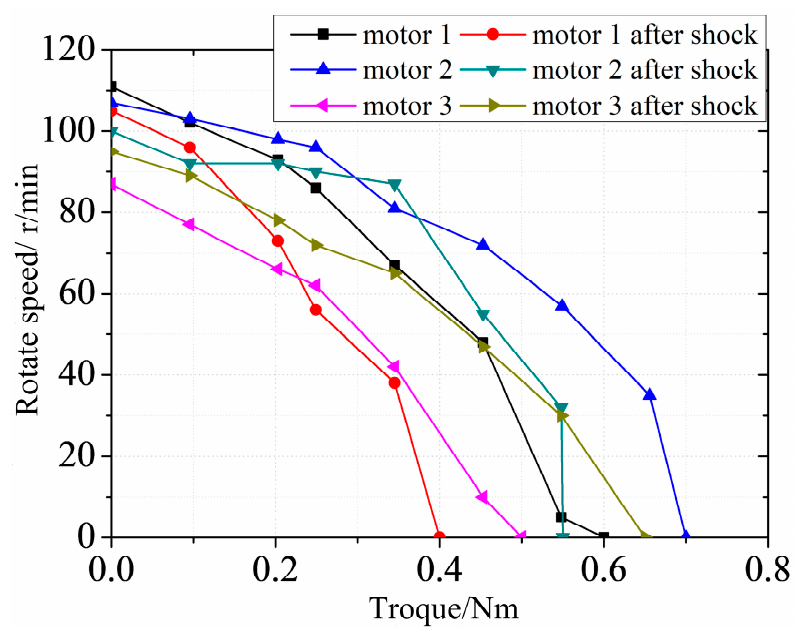
Figure 14. Performance of motors with the protection of rubber.